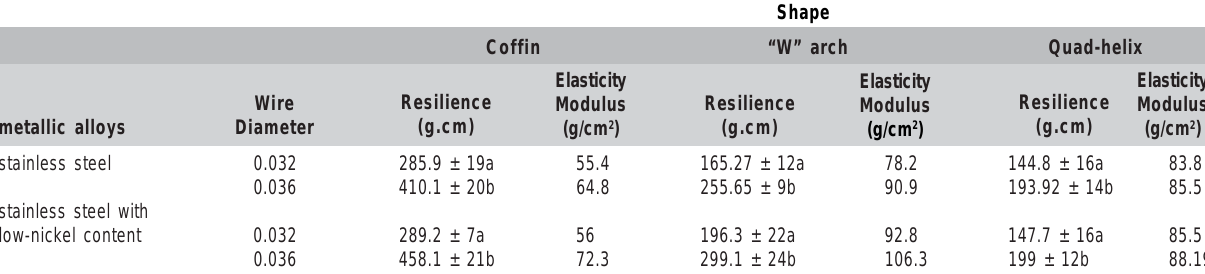
Table 4. Mean resilience and elasticity modulus values produced by the 3 palatal